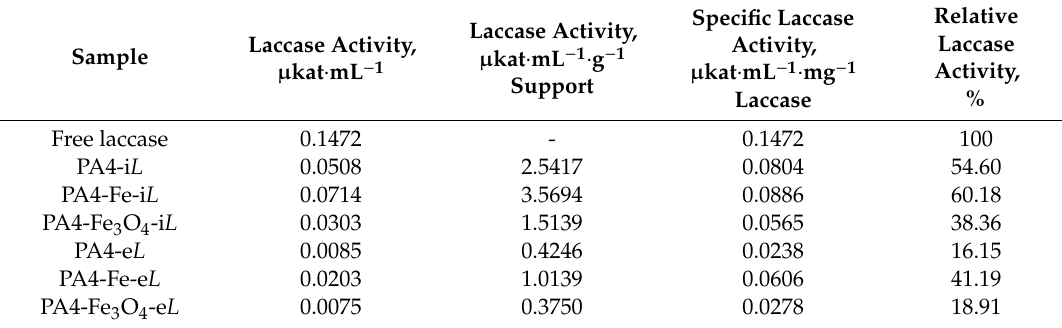
Table 7. Specific activity of laccase immobilized by adsorption or entrapment.